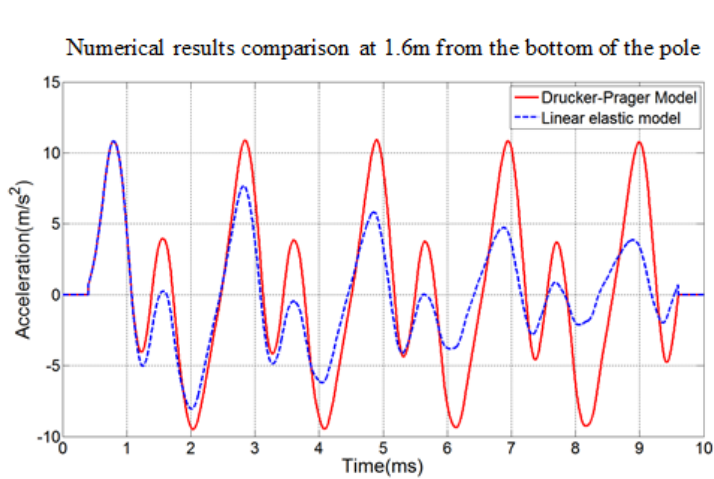
Figure 2. Comparison of numerical results according to different soil modelling methods. Table 2. Material properties of the soil models.